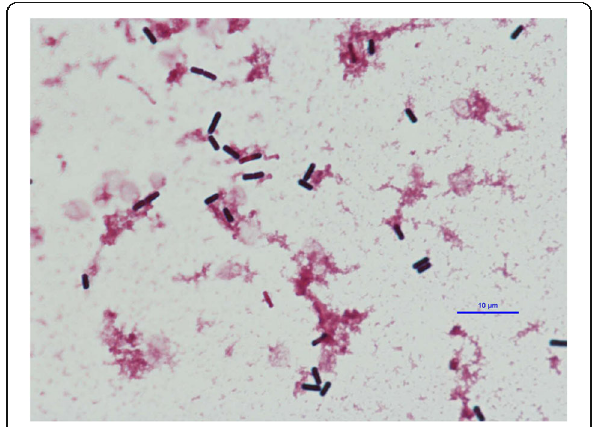
Fig. 3 Bacillus cereus was isolated from two blood sample cultures collected at admission Fig. 4 Chest radiograph indicated extensive bilateral